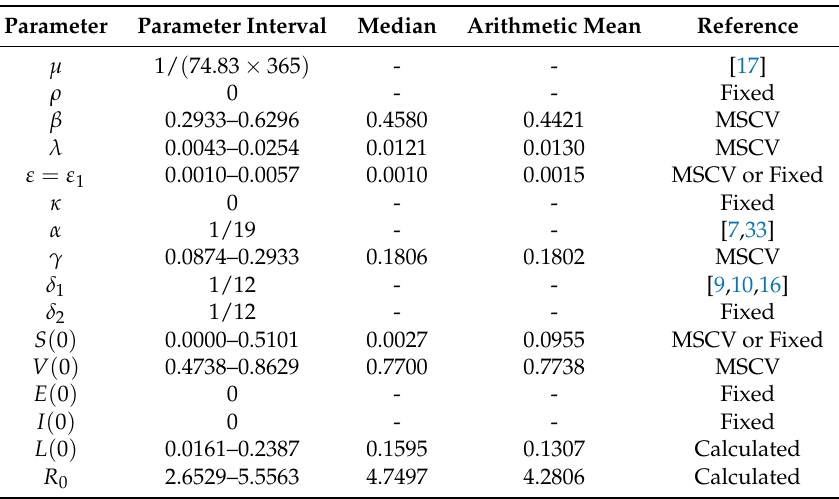
Table 1. Parameters values, initial values and the basic reproduction number, where, ε , ε 1 and S ( 0 ) are estimated through calculating the minimum sum of chi-square value (MSCV) in first half of the year (FHY) and fixed in latter half of the year (LHY).